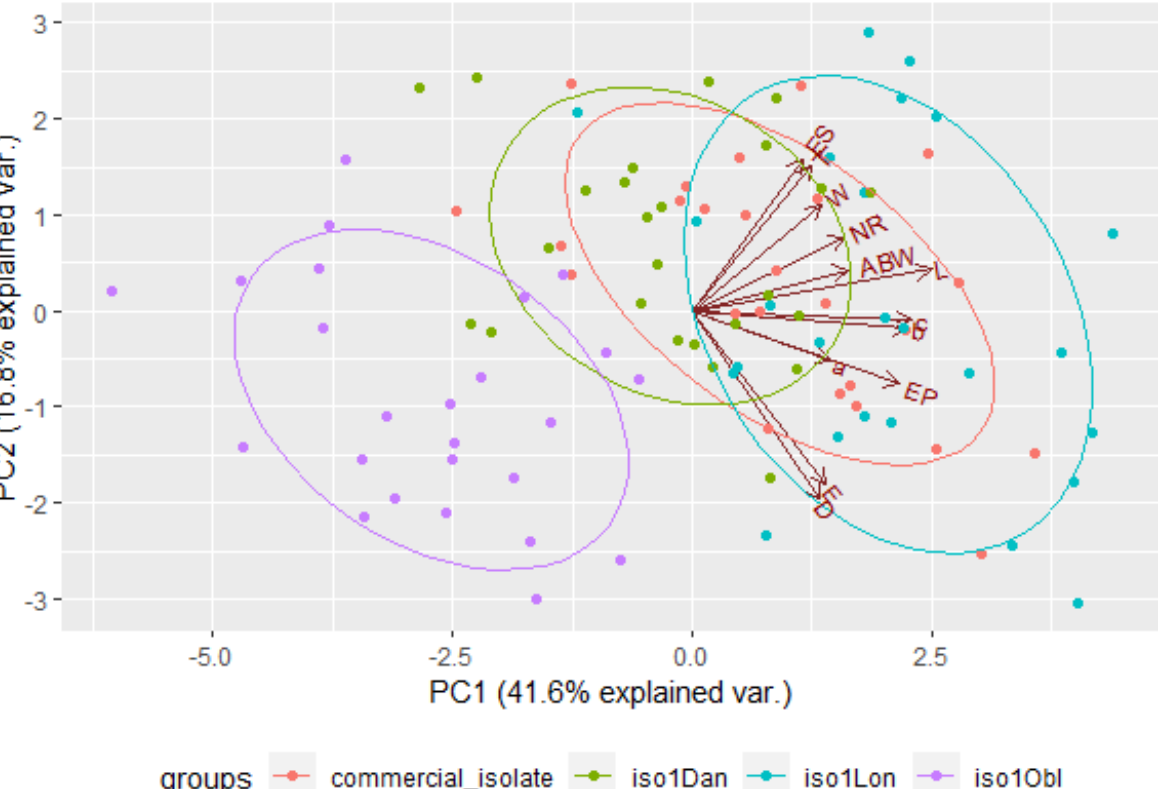
Figure 5. Principal component analysis for infective juveniles—individuals.